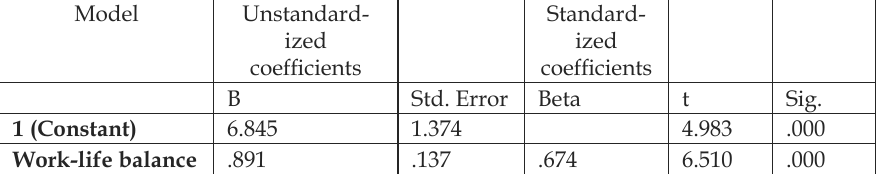
Tab. 10. Predictors of the tendency to leave the organization for the respondents above 35 years. Coef (cid:222)